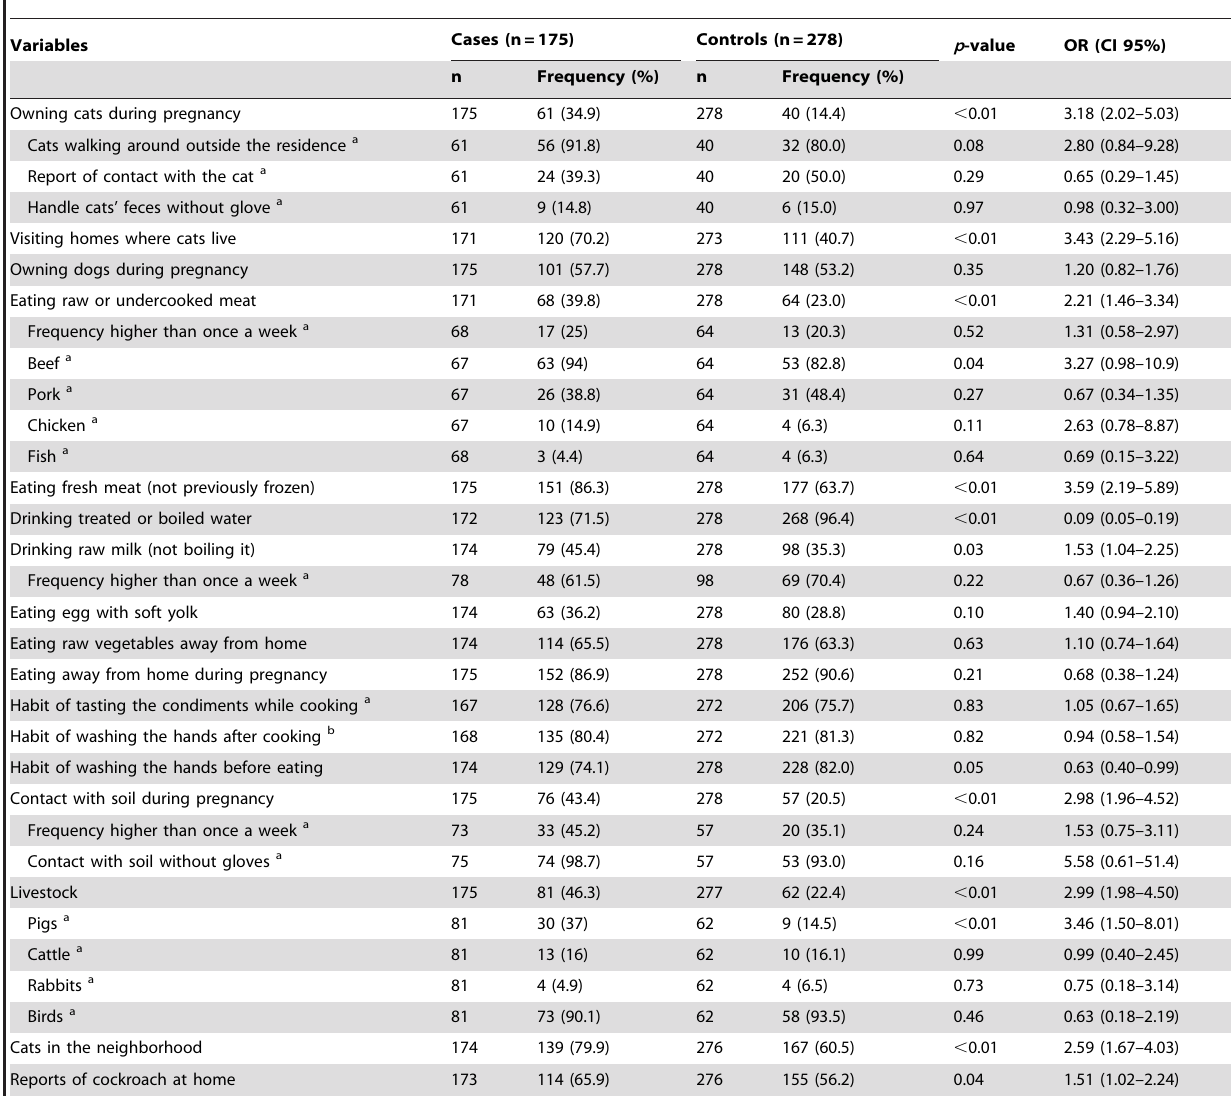
Table 3. Univariate analysis of the lifestyle and environmental factors favorable to the T. gondii transmission among mothers of children with congenital toxoplasmosis and their controls identified in the scope of the newborn screen program of the State of Minas